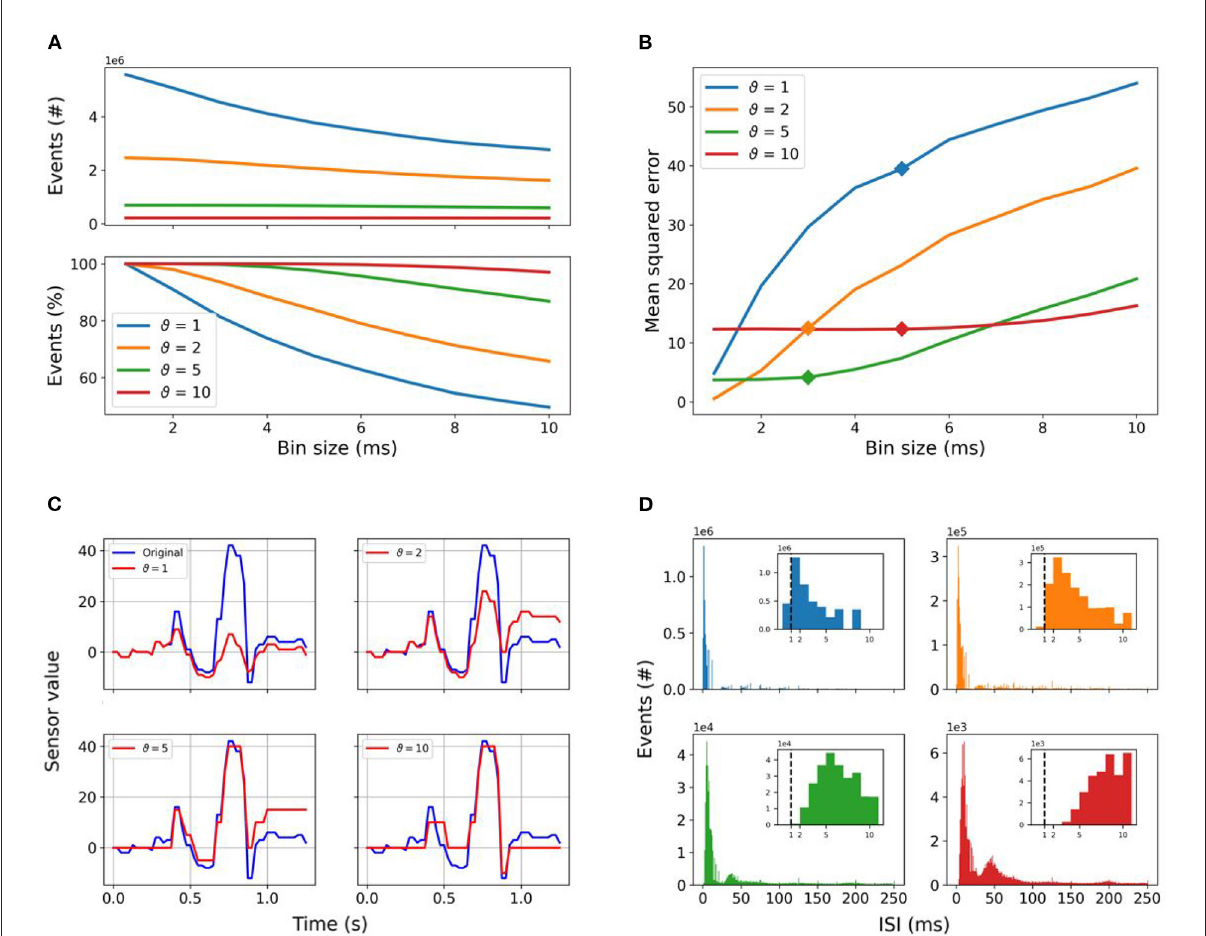
FIGURE4 Spike encoding: (A) Total number of events counted in the whole dataset in dependence of the selected threshold and time _ bin _ size is shown in the top panel, while the relative amount of events found in the dataset relative to time _ bin _ size = 1 is reported in the bottom one. Increasing the encoding threshold reduces the number of events significantly, whereas encoding with lower thresholds is much more affected by increasing time _ bin _ size . The amount of events lost is 50.37% for ϑ = 1, 34.25% for ϑ = 2, 13.17% for ϑ = 5, and only 2.92% for ϑ = 10. (B) MSE values of signal reconstruction after time binning as a function of the time _ bin _ size for each encoding threshold. The time _ bin _ size resulting from the HPO and grid search used to preprocess the event stream are highlighted by the markers. Panel (C) shows the reconstruction of the frame-based signal from the event stream for all given thresholds after time binning with a bin size of 5 ms. (D) Number of events as a function of the ISI with fixed time _ bin _ size as reported in Table 2, with the same color coding as in (A,B) . The insets show the detail at ISI values equal to the time _ bin _ size used in this work, highlighting the minimum temporal resolution of 1 ms with the vertical dashed line. Spikes below 1 ms in percentage of total number of spikes: 8.22% for ϑ = 1, 0.45% for ϑ = 2, 0% for ϑ = 5, and ϑ =